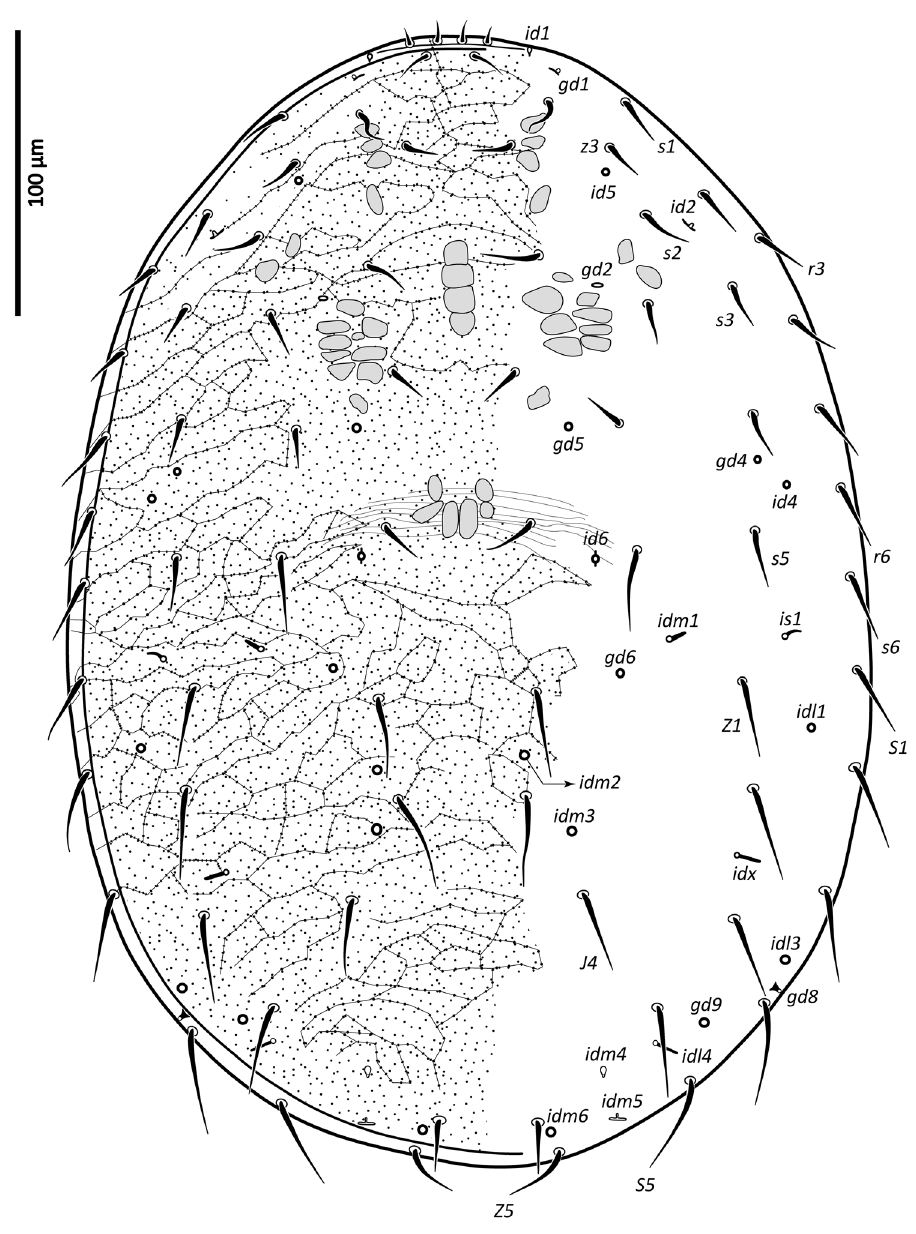
Figure 15. Zygoseius lindquisti sp. n., female, dorsal idiosoma.